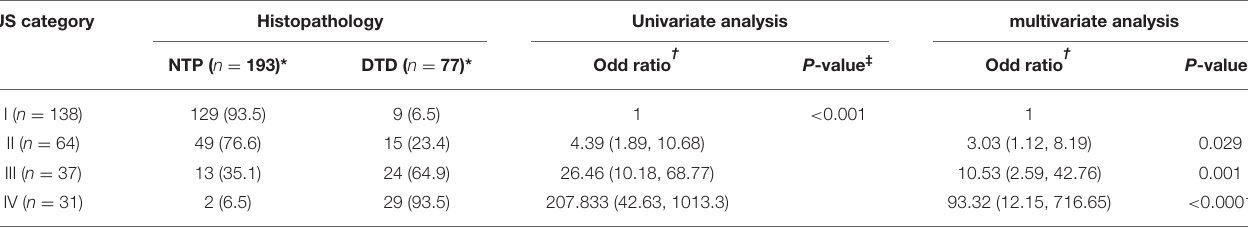
TABLE 2 | Ultrasonography categories in the thyroid imaging reporting and data system for diffuse thyroid disease and the corresponding histopathological results for the thyroid parenchyma. US